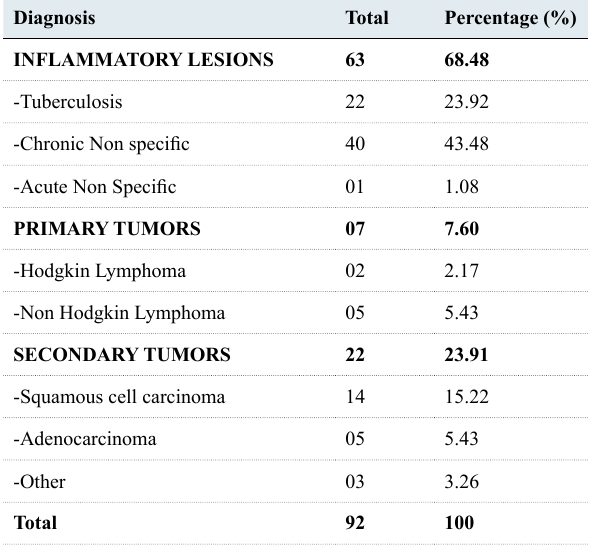
Table 1: Incidence of various causes of lymphadenopathy (n=92)